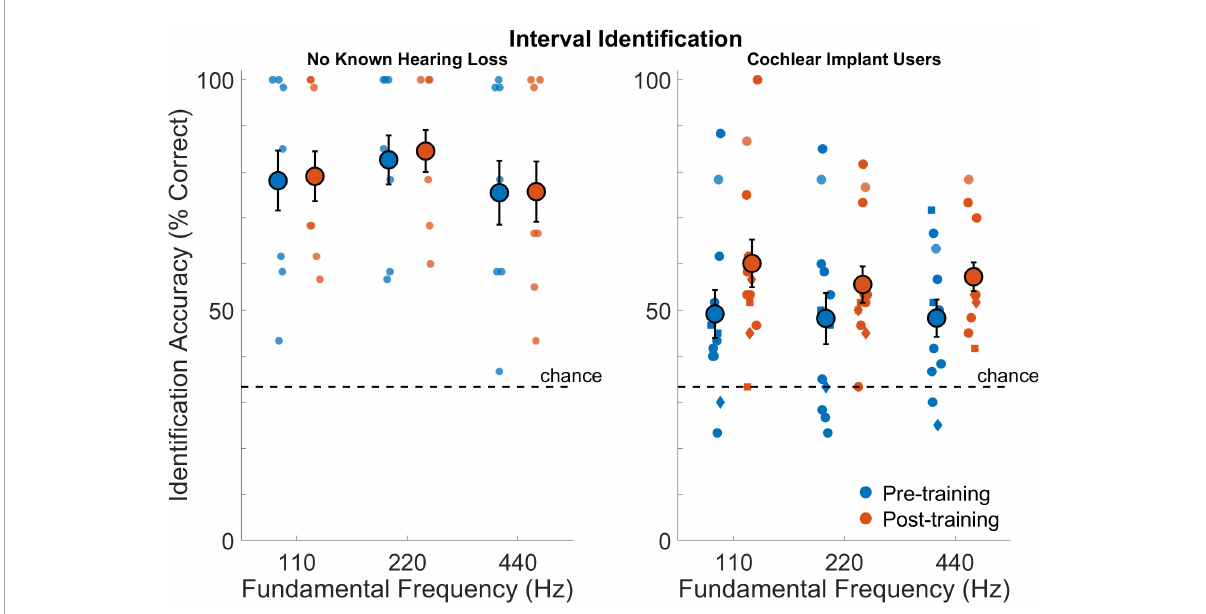
FIGURE6 Interval identification as percentage of correct responses for participants with no known hearing loss (left subpanel) and for cochlear implant users (right subpanel) at 110, 220, and 440 Hz. Smaller symbols indicate individual thresholds. Individual thresholds for cochlear implant users with implants from Cochlear Corporation are represented with a circle, Advanced Bionics with a diamond, and MED-EL with a square. Larger circles indicate group averages for each session with error bars indicating standard errors of the means.